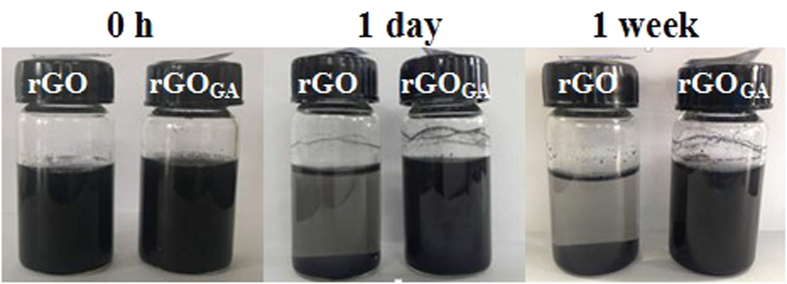
Dispersions of rGO and rGOGA in aqueous solution at different time intervals (~1mg/mL).